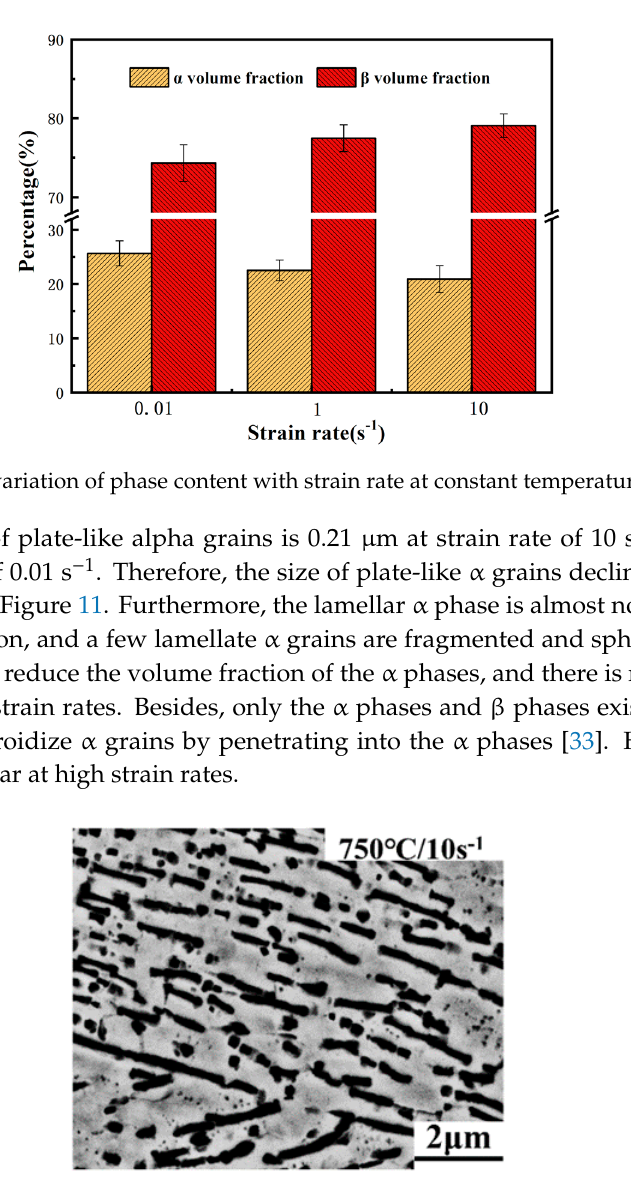
Figure 11. The size and morphology of α phases at deformation temperature of 750 °C and strain rate of 10 s − 1 .